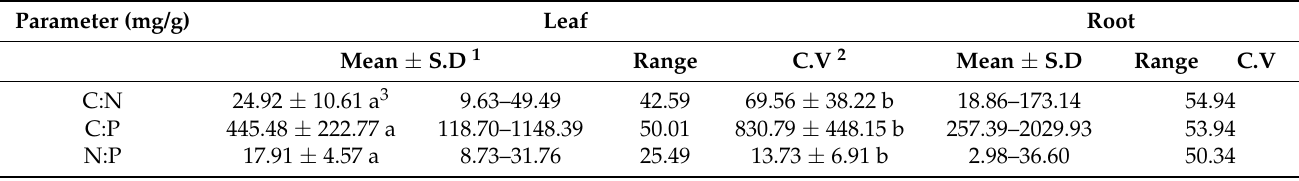
Table 2. The stoichiometric distribution characteristics of shrub leaves and roots. Parameter